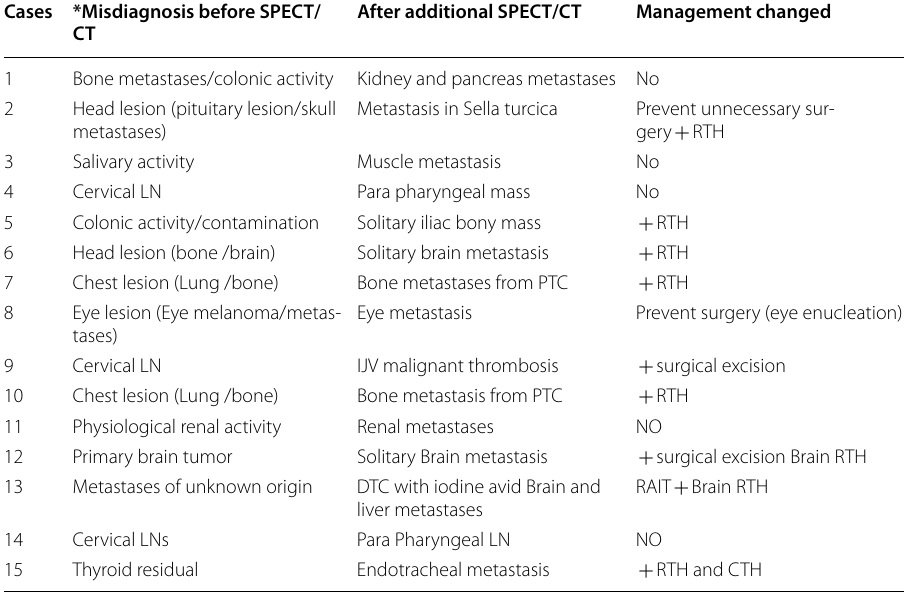
Table 3 Change in patients’ management after addition of SPECT/CT for characterization of RM